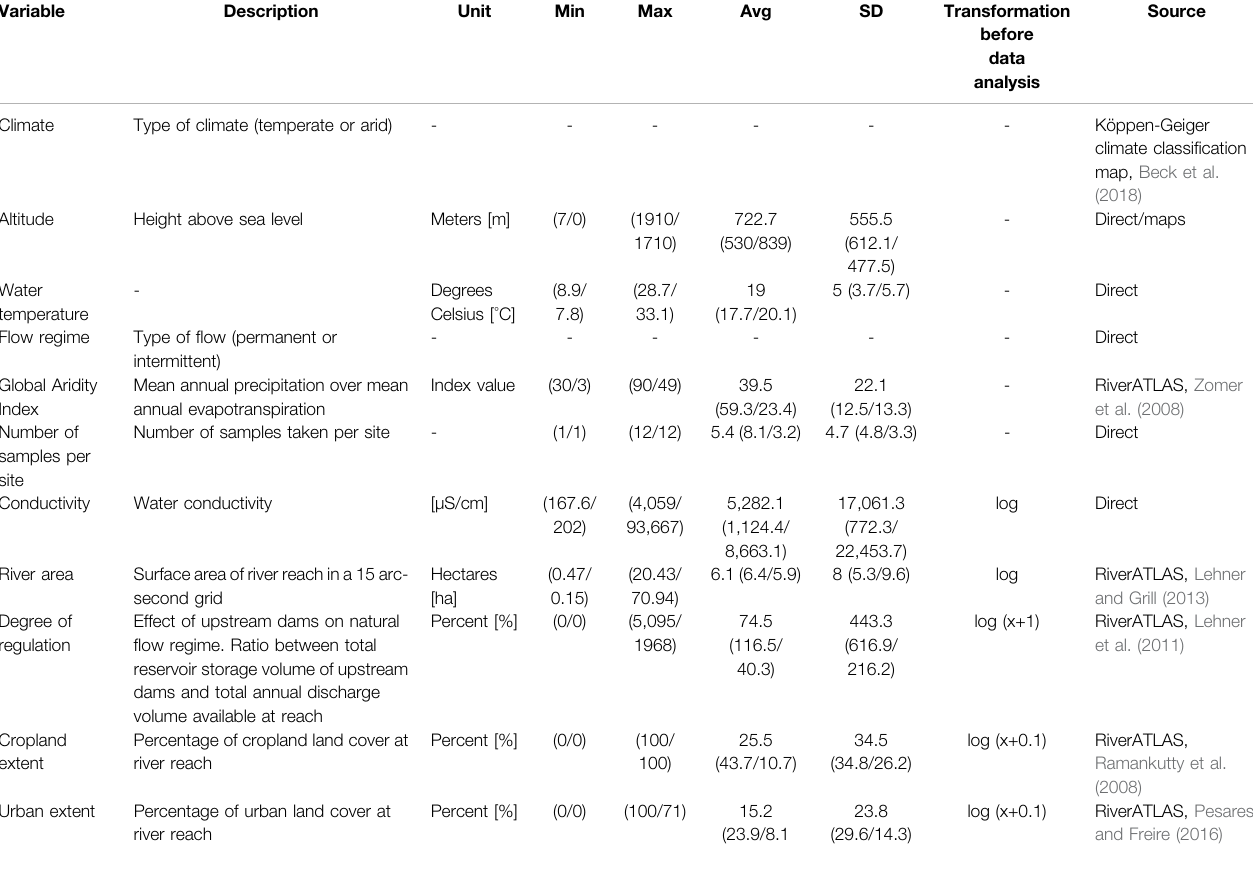
TABLE1| Environmentalandanthropogenicvariablesusedintheanalyseswiththeirunit,minimum(Min),maximum(Max)andaverage(Avg)values,standarddeviation(SD), used transformation before data analysisand thesource ofthe variables ( “ direct ” indicates direct extraction from publications). Values for temperate and arid climateare reported in brackets, separated by a